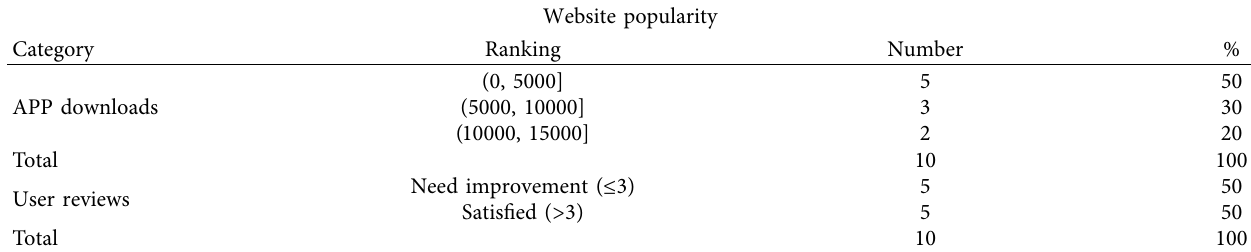
Table 12: Summary of the popularity of the APP.